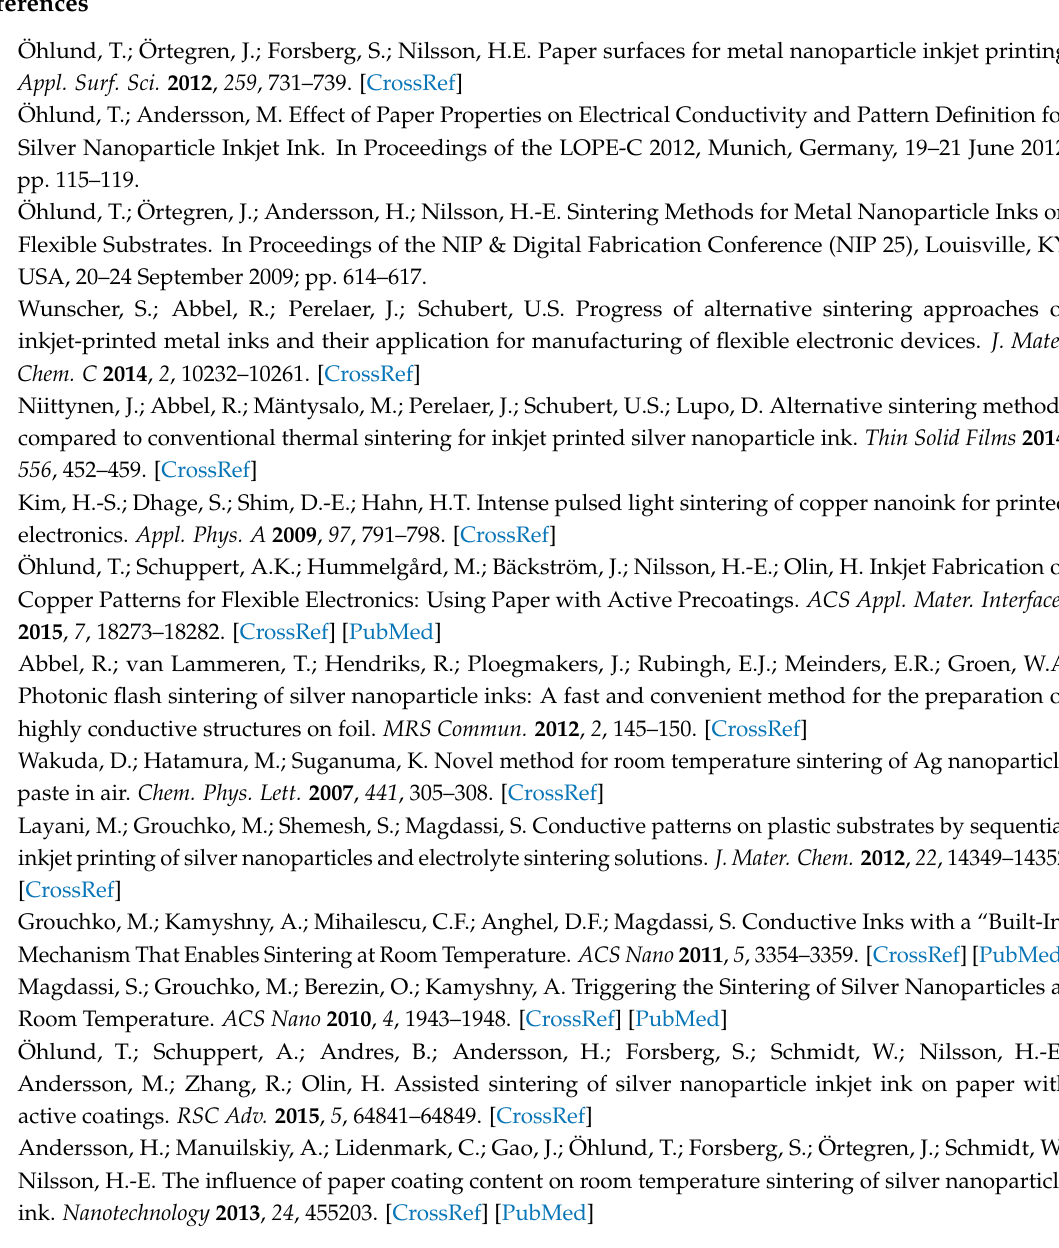
Figure S1: SEM images of AgCl formation on top of the AgNP